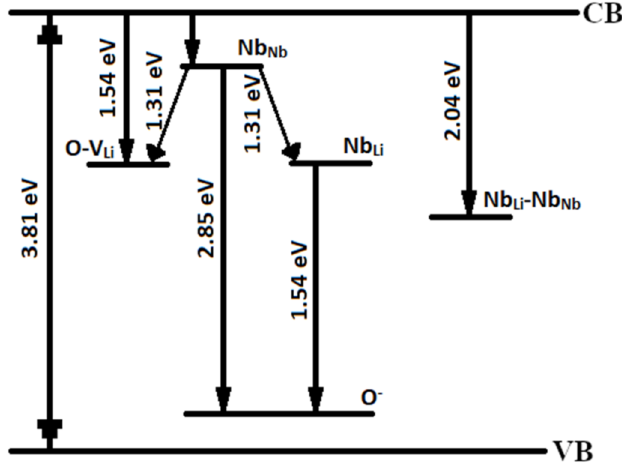
Figure 8. An enhanced scheme of the main channels of radiative recombination in the visible region according to the fundamental absorption edge and PL of CLN